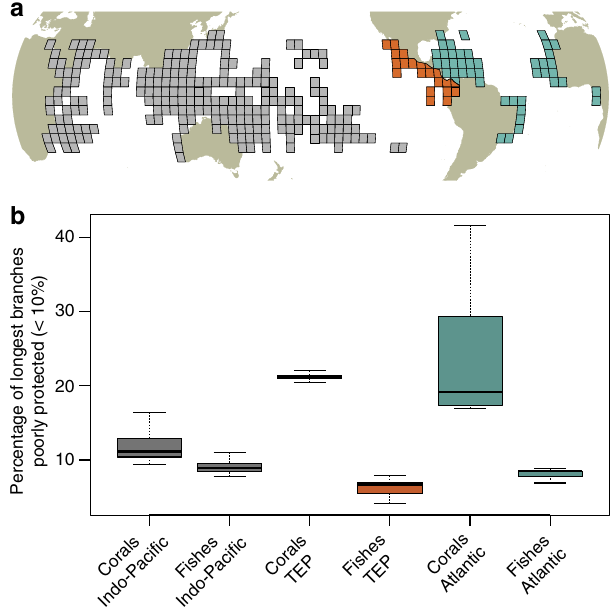
Figure 5 | Representation in MPAs for branches of the Tree of Life on coral reefs across marine realms. ( a ) Global map representing the three marine realms: Indo-Pacific (grey), Tropical Eastern Pacific (orange), and Atlantic (green). ( b ) Boxplots (median and quartiles) representing the percentage of the longest evolutionary branches (top 10%) that receive less than the critical 10% coverage by the MPA system within coral and fish local assemblages (in 5 (cid:2) (cid:2) 5 (cid:2) grid cells) of the three marine